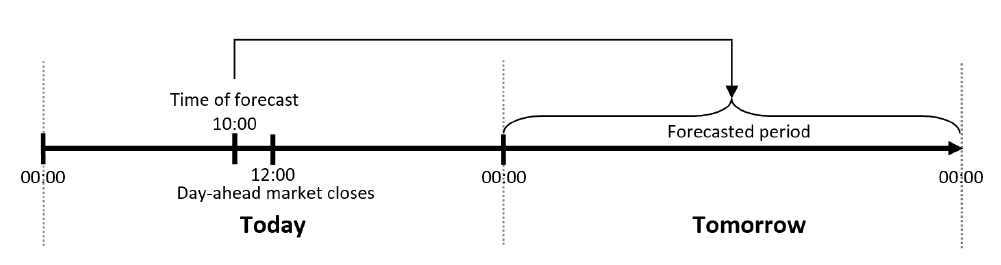
Figure 1. Timeline for the heat load forecast that is relevant for the trading decisions in the day-ahead electricity market. Every day at 10:00 a forecast is produced for each hour of the following